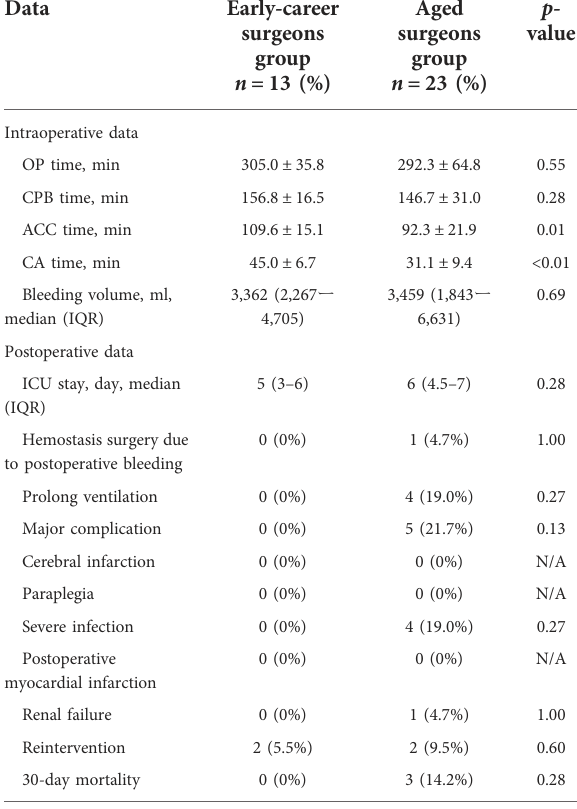
TABLE 3 Comparison of early-career surgeons and aged surgeons within group